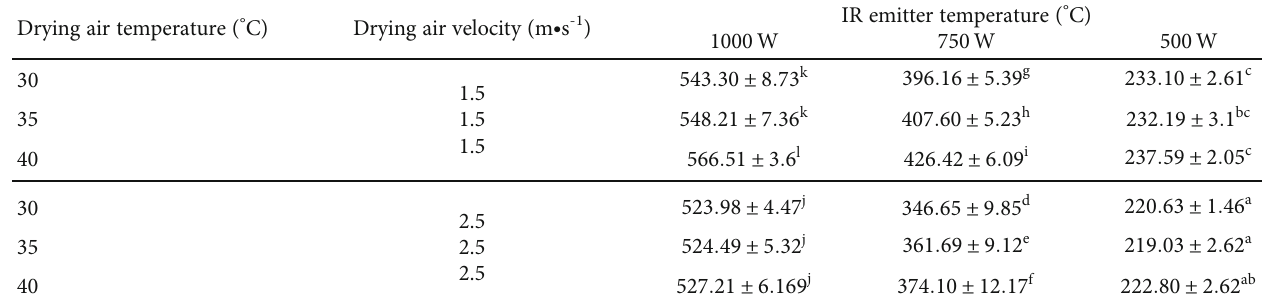
Table 2: Temperature of the IR